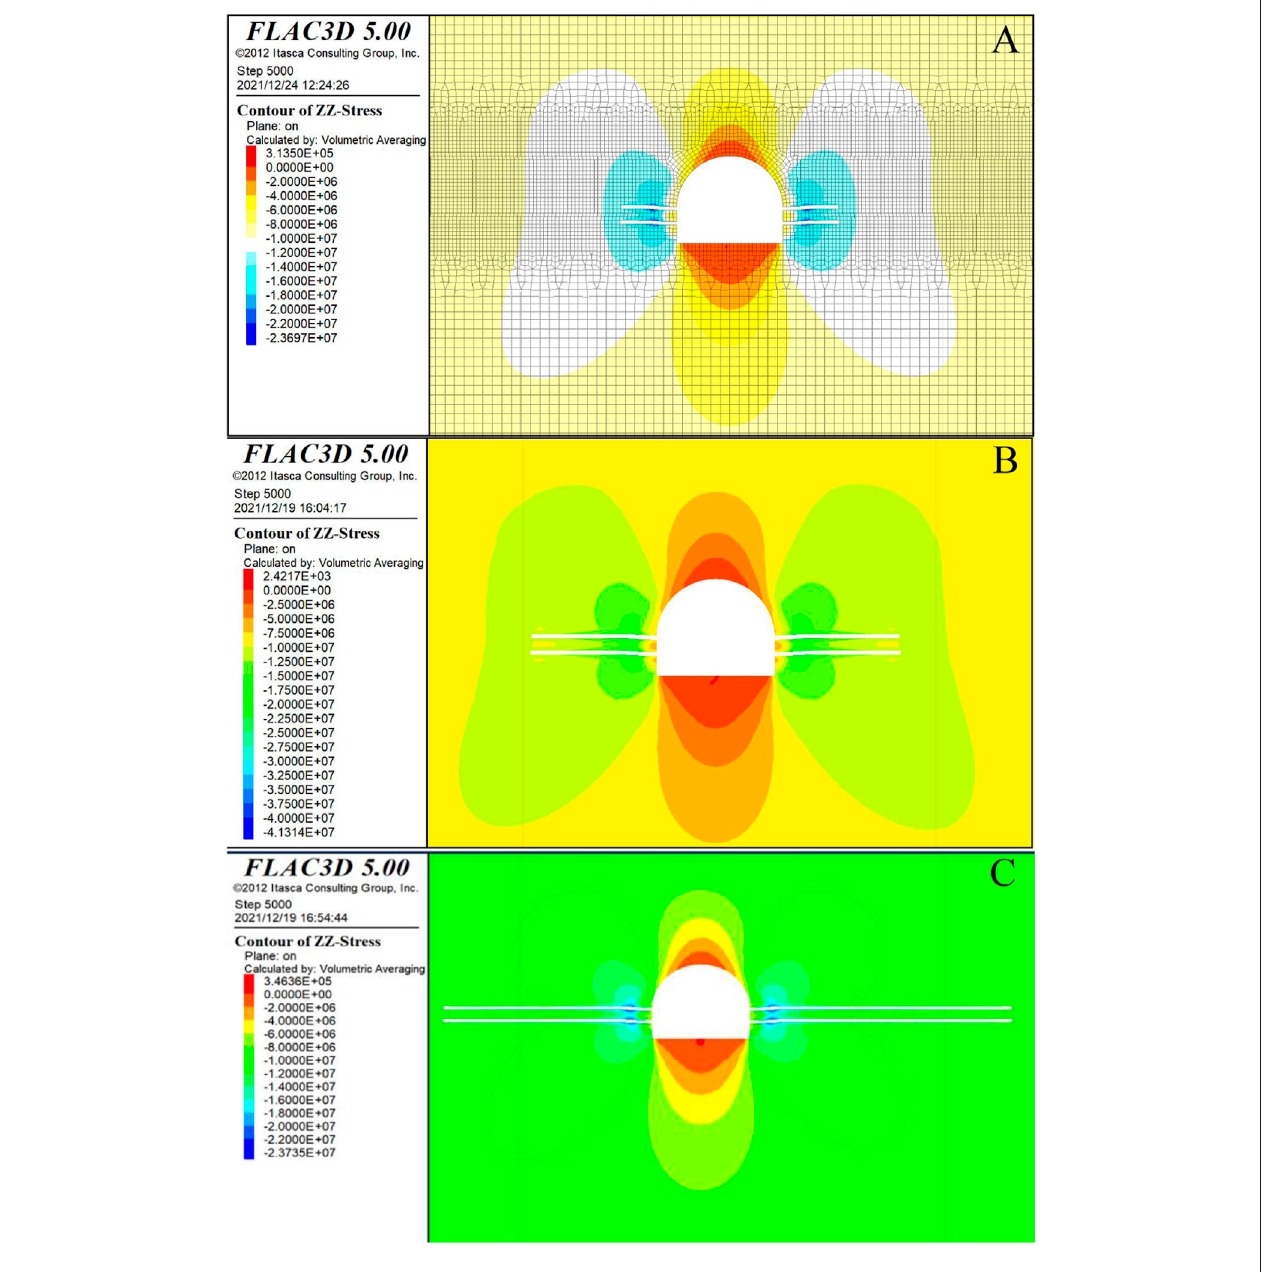
FIGURE 8 | Borehole pressure relief ZZ stress distribution nephogram. (A) Option 13. (B) Option 14. (C) Option 15.